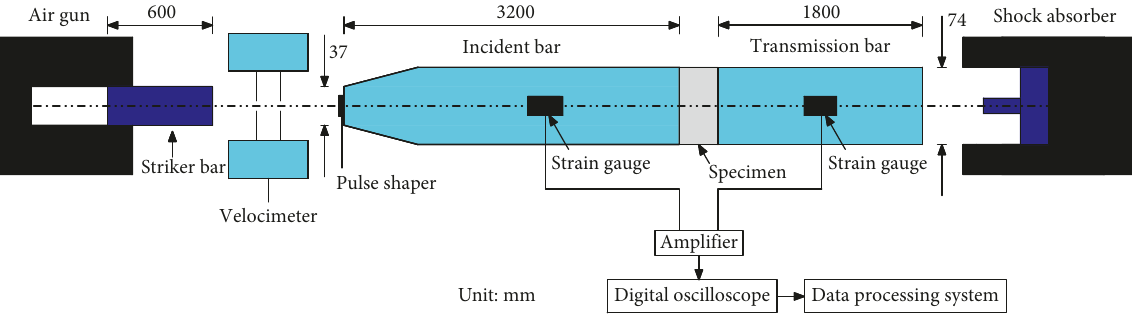
Figure 3: Schematic of the SHPB device for the compression